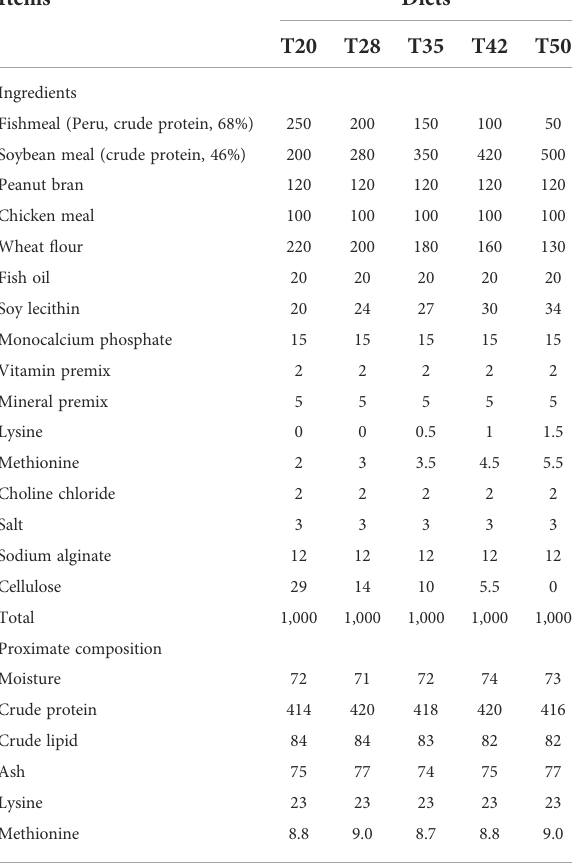
TABLE 1 Ingredients and proximate compositions (g/kg DM) of experimental diets.